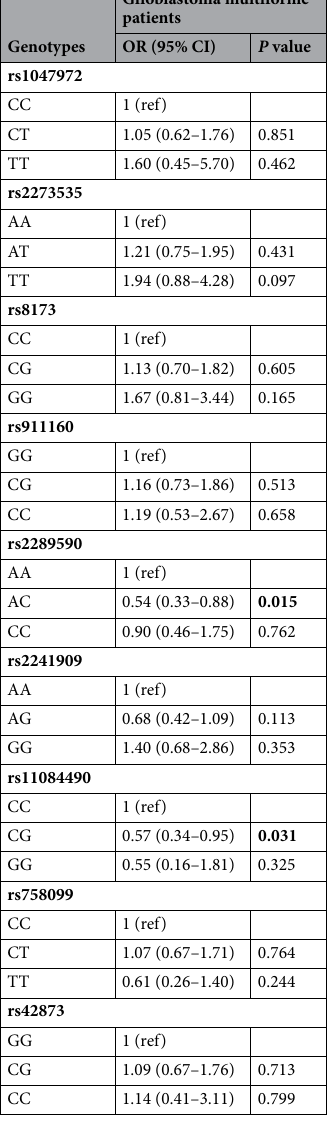
Table 4. Risk of glioblastoma multiforme associated with the studied genetic variants. OR odds ratio, CI confidence interval, Ref reference homozygote. ORs, 95% CIs and P values were obtained by multinomial logistic regression analysis. Statistically significant values are highlighted in bold characters ( P ≤